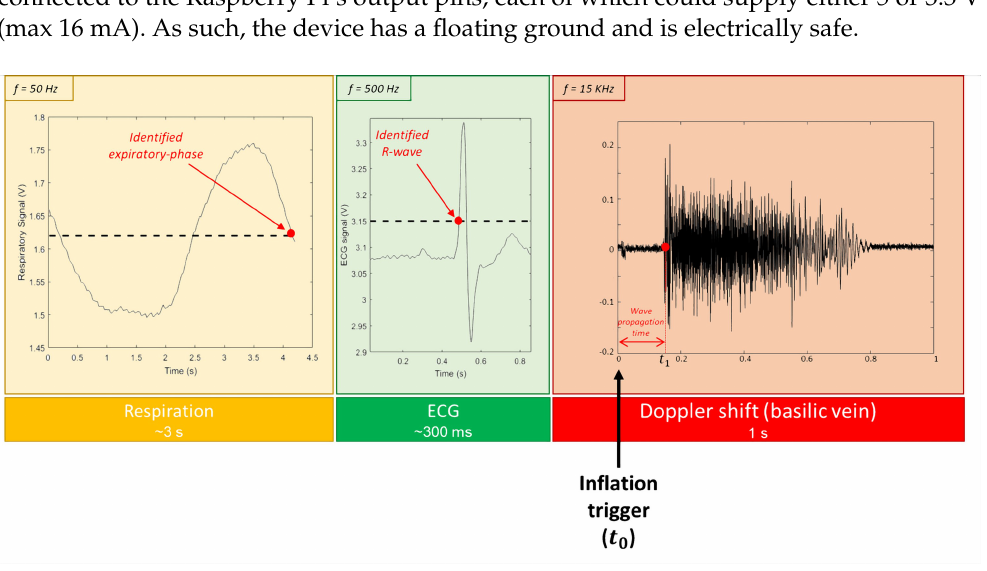
Figure 3. Signal acquisition timeline, typical timing, and signal waveforms. (right) Gaemodynamic response to compressive stimulus reported in time domain. Compressive stimulus delivered at time 0 of Doppler acquisition, and pulse transit time t 1 could be easily